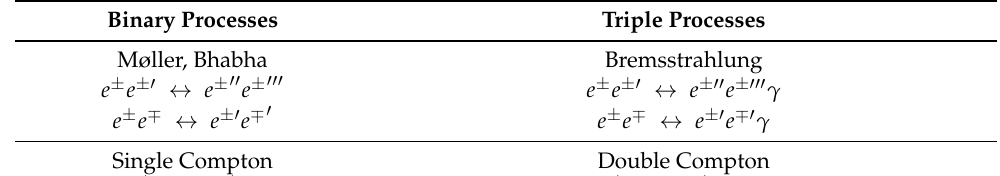
Radiative pair production, triplet production and